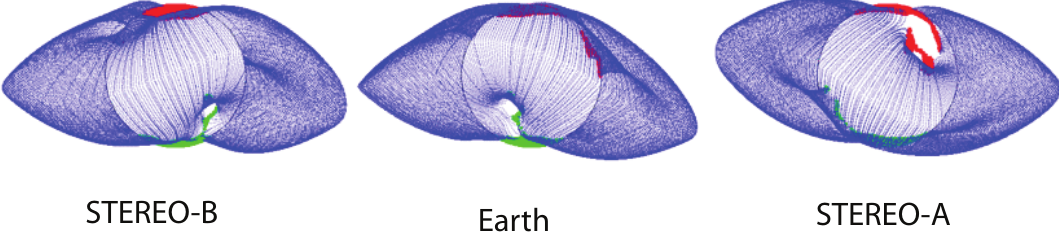
Fig. 6. Potential-field source-surface models of simulated line-of-sight views from (left) STB, (middle) Earth, and (right) STA from Global Oscillation Network Group (GONG). Closed streamer belt field lines are shown blue. Positive and negative coronal hole open field regions are indicated by green and red,